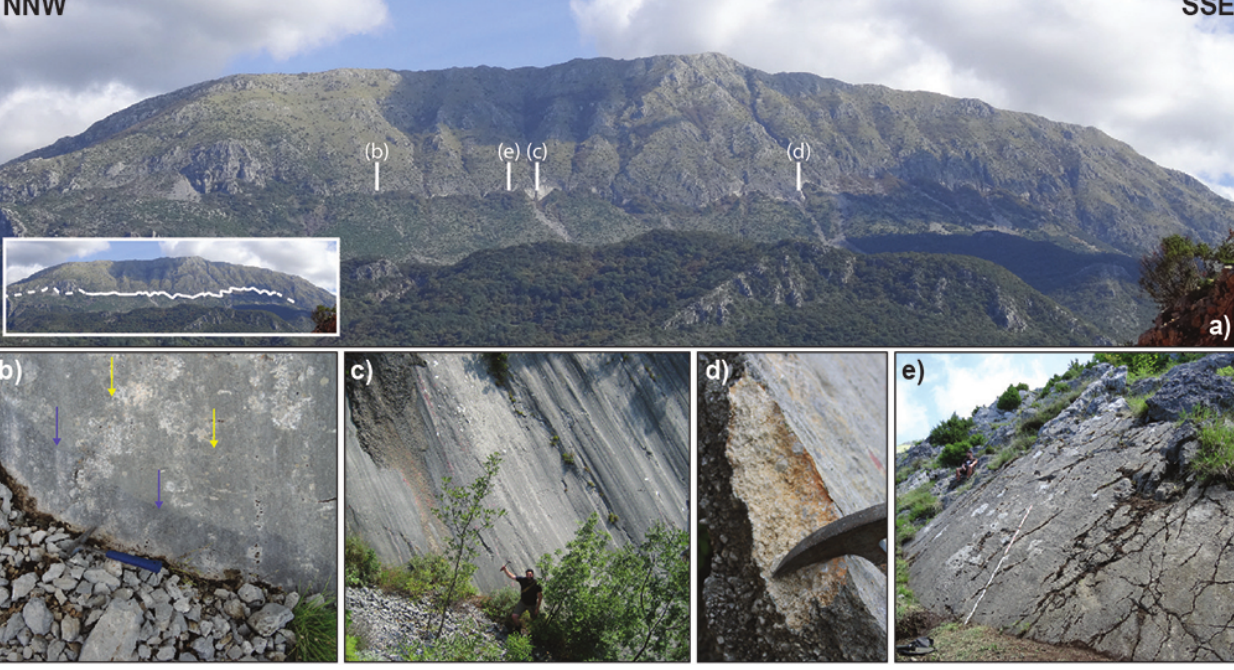
Figure 3. Photographs of the northern section of the Bar fault scarp (BFS N ): (a) panoramic view, with the fault trace shown in the inset. (b) Repeated earthquake ribbons; hammer for scale. Arrows: blue – young; yellow – older. (c) Fault plane outcrop with characteristic corrugations and oblique-slip lineations; person for scale. (d) Cataclastic fault breccia in the footwall of the fault plane; hammer for scale. (e) Sampling site BFS N , with a 2m ruler for scale; for localization see Fig.